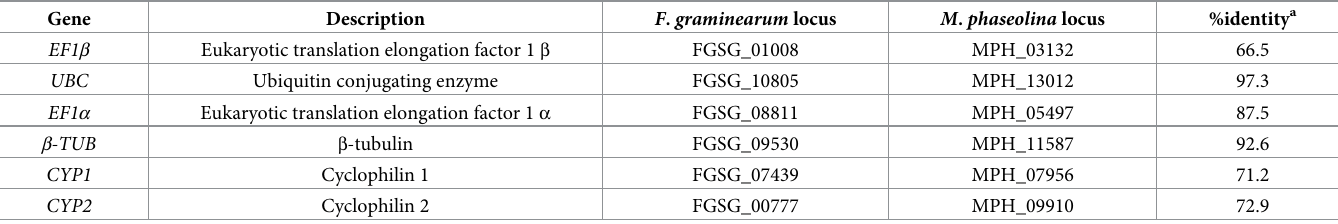
Table 1. List of candidate reference genes homologous to those evaluated in F . graminearum .